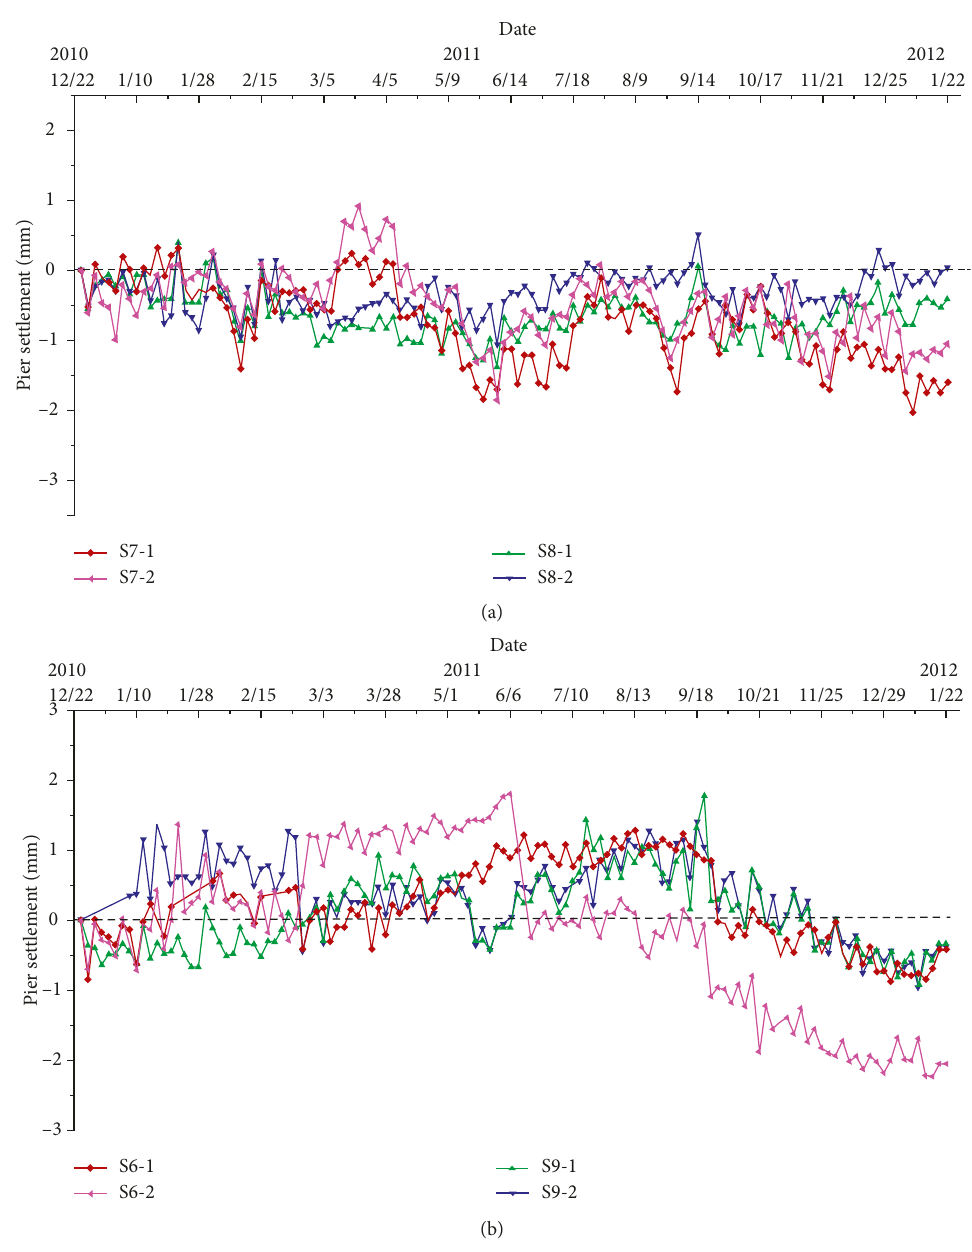
Figure 12: Settlement curve of pier: (a) S7 and S8; (b) S6 and